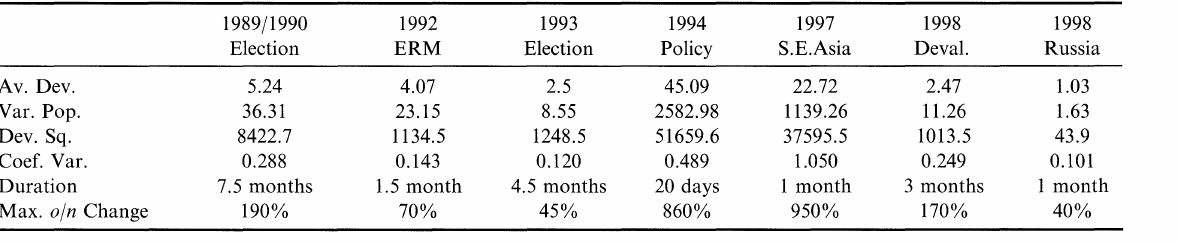
Main statistics and special features of selected runs against the Greek Drachma